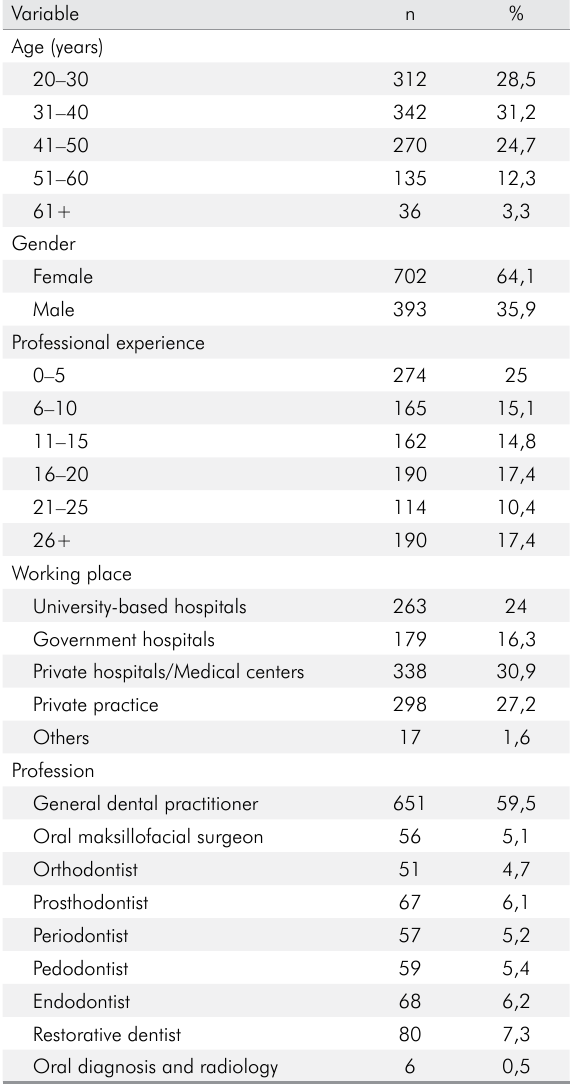
Table 1. Frequency distribution of dentists’ demographic